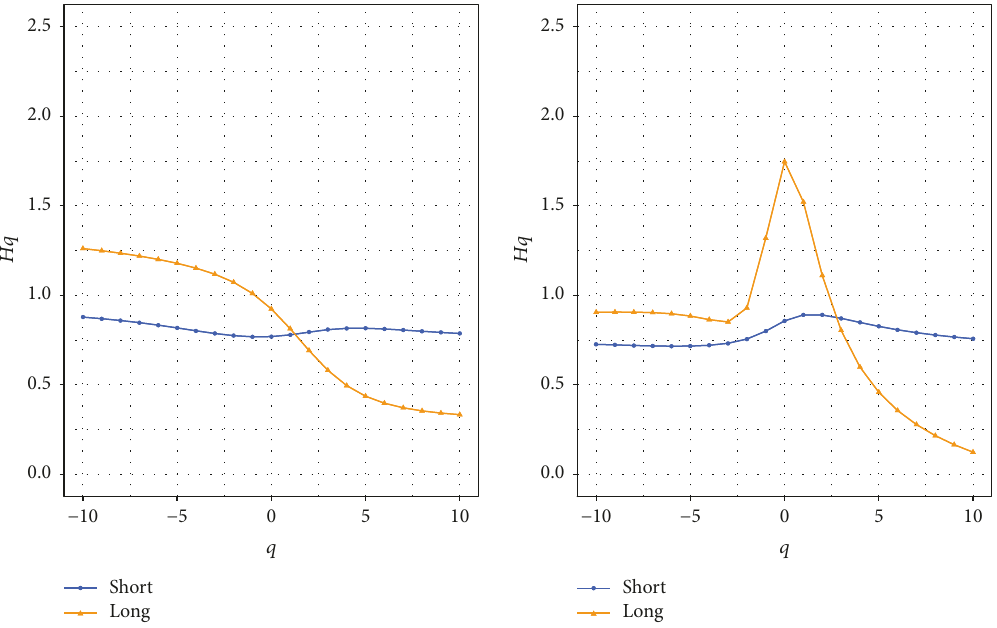
Figure 8: Short and long scaling exponents for MM-Return and NM-Return.